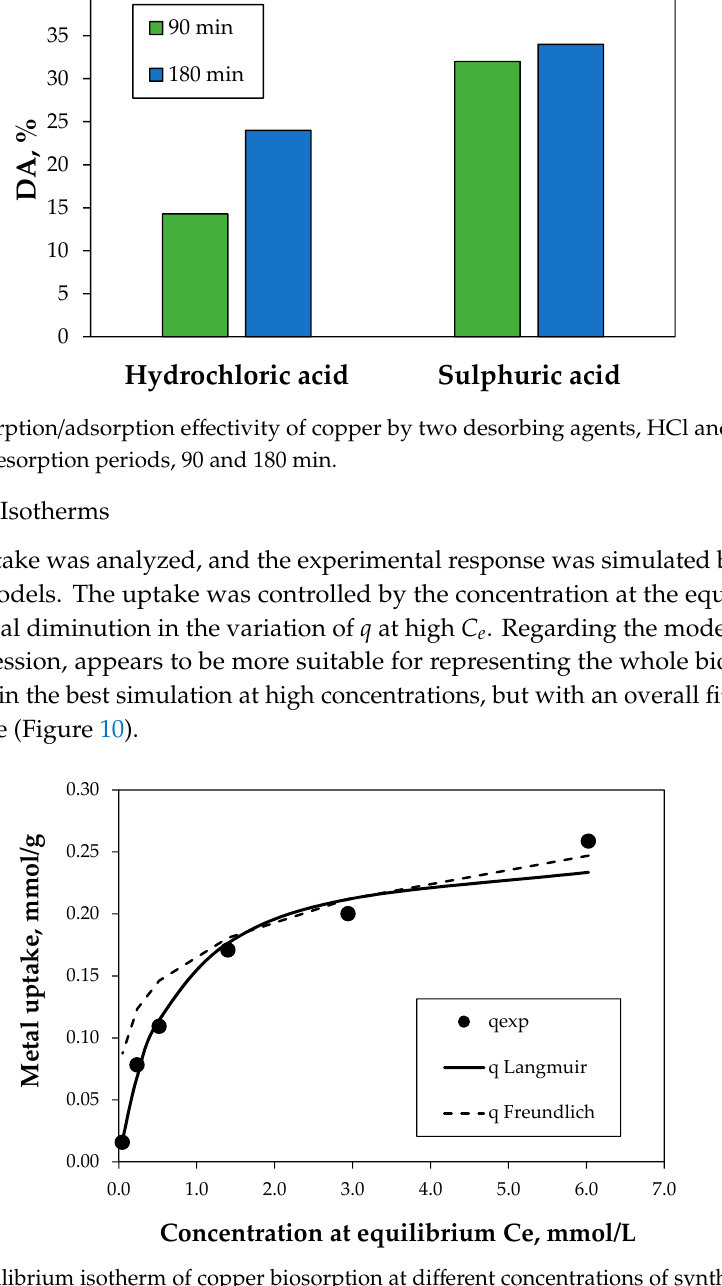
Figure 10. Equilibrium isotherm of copper biosorption at different concentrations of synthetic solution for 10 h. Biomass concentration of 1 g / L and pH 3, q exp denotes the experimental metal uptake, q L and q F represent the Langmuir- and Freundlich-simulated metal uptakes.